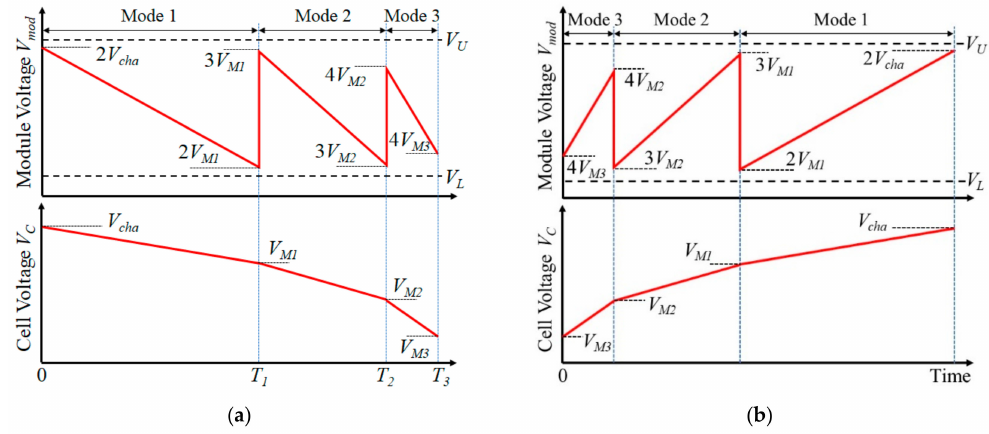
Figure 9. Module voltage V mod and cell voltage V C in ( a ) discharging and ( b ) charging.